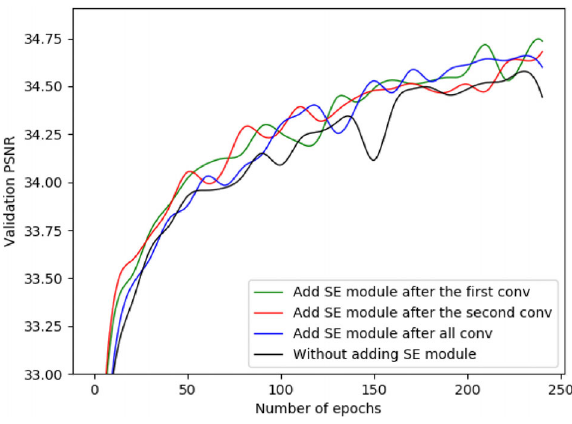
Fig. 3 Effects of adding SE module in different positions on the model.